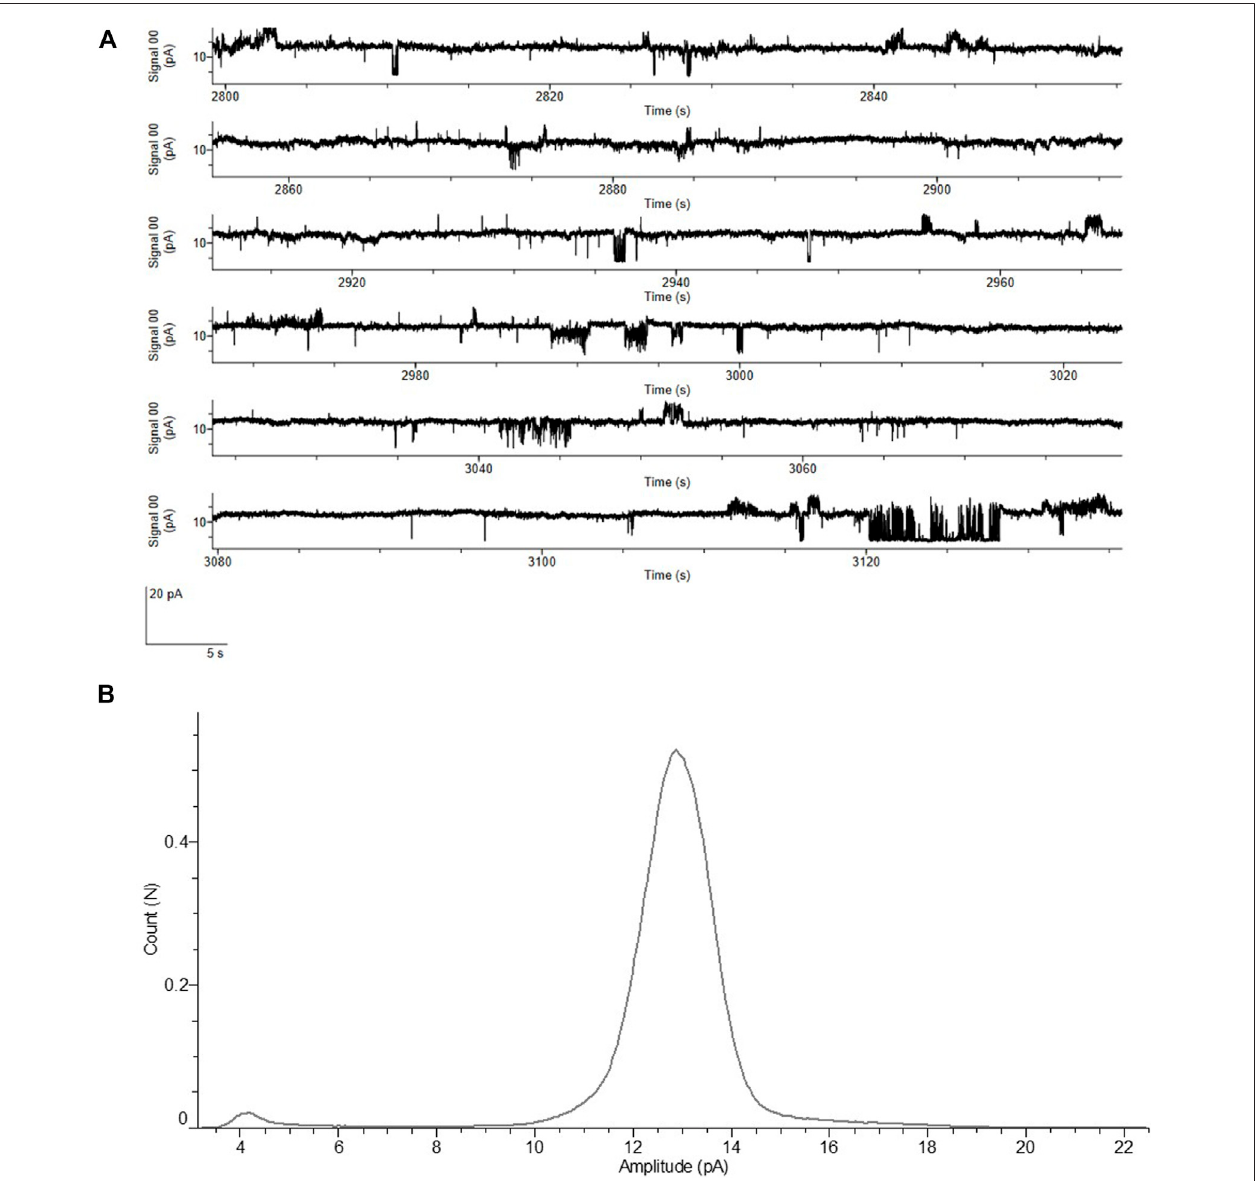
FIGURE 7 | Functional analysis of ORF4 envelope protein reconstituted into lipid bilayer. (A) Current recordings at a voltage clamp of +100 mV from the ORF4 reconstitutedintoDPhPCbilayer. (B) AllpointHistogramplottedfromthecurrentrecordingsshowingthelargepeakat13 pAindicatingastablepore.Allmeasurements of ORF4 were done in the presence of 150 mM NaCl, 10 mM HEPES, pH 7.0 buffer ( n =